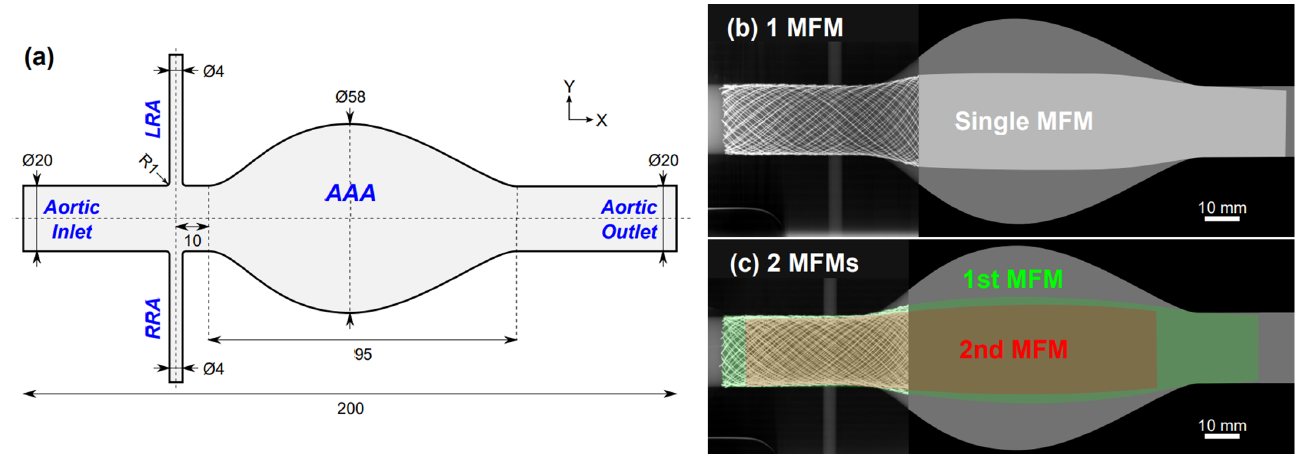
Figure 1. ( a ) Lumen geometry of the infrarenal AAA model. All dimensions are in mm. Aortic flow direction is from left to right. ( b , c ) Schematic of deployed MFM devices including micro-CT reconstruction near the aorta-renal bifurcations in single and overlapped cases, respectively. Color code for the overlapped case is green and red for outer and inner MFM, respectively.